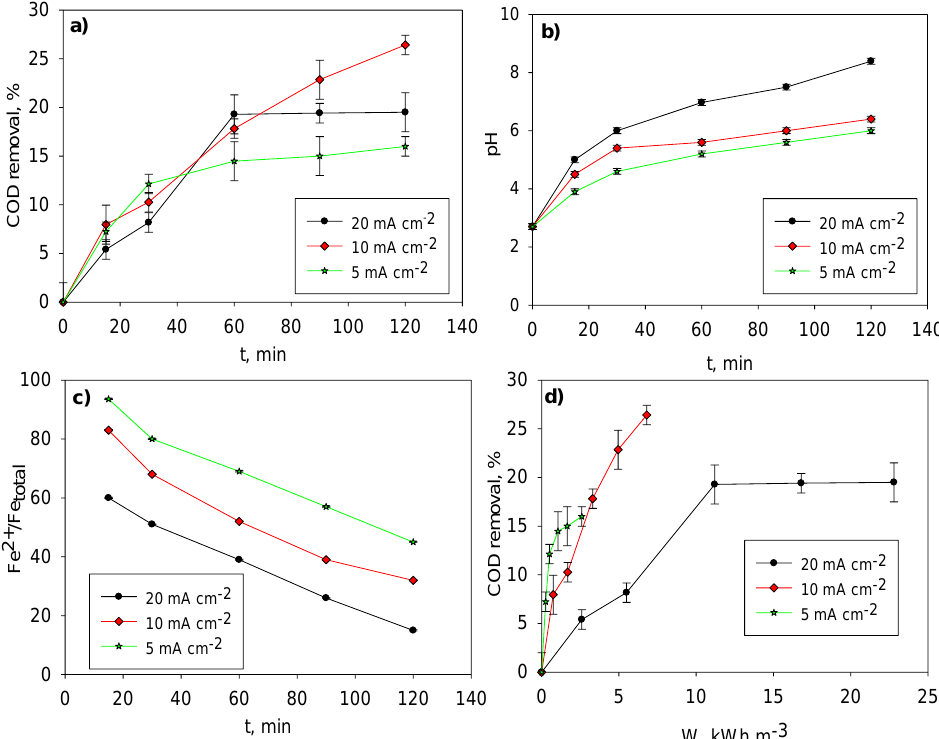
Figure 2. Current density optimization for the electro-coagulation treatment (at 3 cm of electrodes distance) of conventionally coagulated landfill leachate (at pH = 5 and 2 g L −1 of FeCl 3 6H 2 O): ( a ) COD removal evolution along treatment; ( b ) evolution of pH along treatment; ( c ) distribution of iron species during the process; and ( d ) COD removal vs. power consumption.